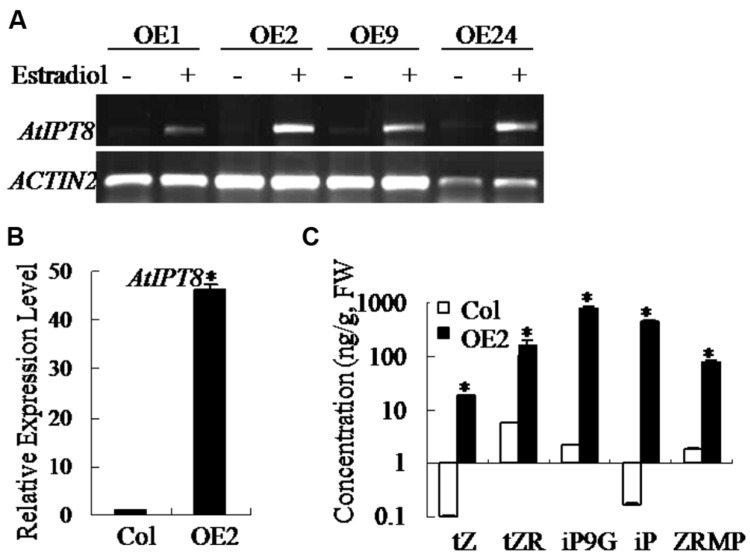
Overexpression of AtIPT8 promoted overproduction of endogenous cytokinins in Arabidopsis. Asterisk symbols (∗) indicate p < 0.05 (Student t-test). (A) Semi-quantitative RT-PCR to examine the expression levels of AtIPT8 in independent 17-β-estradiol-inducible transgenic lines. Overexpressing AtIPT8 transgenic lines (OE1, OE2, OE9, and OE24) showed higher expression levels of AtIPT8 in an estradiol-dependent manner. ACTIN2 was used as the internal control. Estradiol: 17-β-estradiol (10 μM). (B) The AtIPT8 expression level was more than 40-fold higher in OE2 plants after 10 μM 17-β-estradiol treatment for 24 h. The values of Y-axis indicate means ± SE (standard errors) of three independent experimental repeats. (C) The cytokinin varieties in the 2-week-old seedlings of Col and OE2 were quantified using GC-MS. Seedlings of OE2 were pre-treated with 10 μM 17-β-estradiol for 24 h. The data represent the means ± SE of two reproducible experiments (fresh weight, FW).